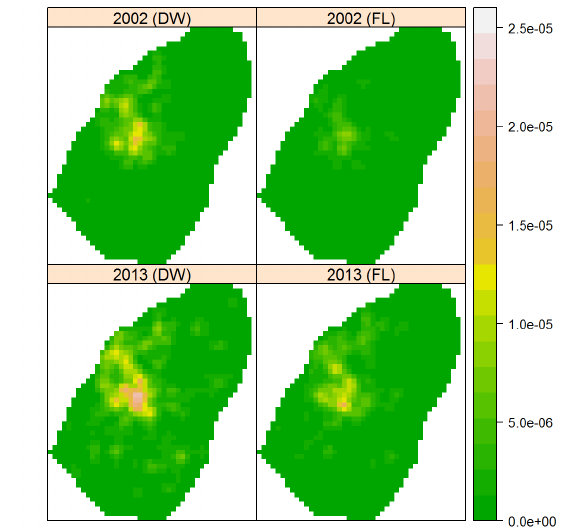
Figure 3. KDE for DW and FL fires in 2002 and 2013 defined as the proportion of a particular type of fire to all the fires. In this way, the fire of higher significance to a place can be identified and thus be emphasized in future fire prevention programs. Specifically, the study area is represented by a set of regular grid cells (1.0 km * 1.0 km), and the number of all fires as well as of each category is calculated for each cell. The LISA analysis results (p-value < 0.05) for DW and FL fires (years